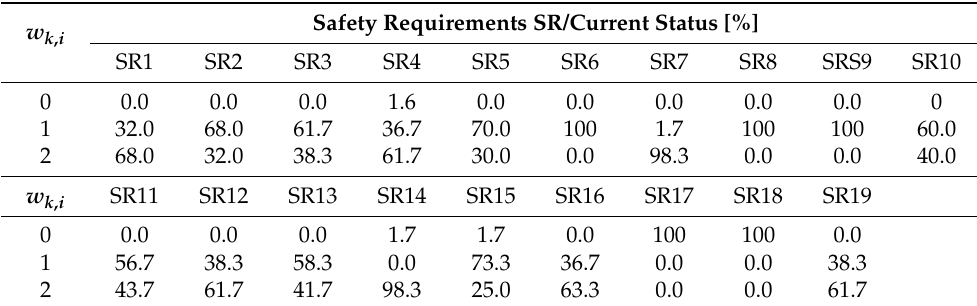
Table 5. Status of current measures for safety requirements in an organization (n = 60)